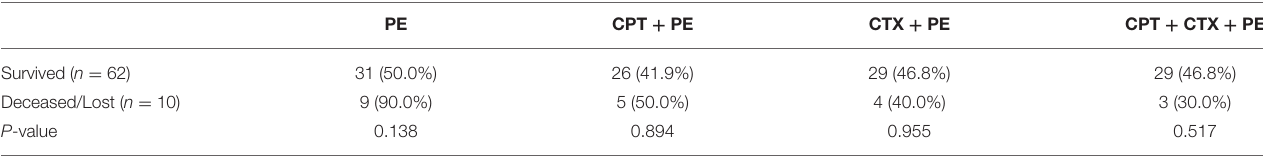
TABLE 4 | Comparisons of treatment between the survival and the deceased group. PE CPT + PE CTX + PE CPT + CTX + PE Survived ( n = 62) 31 (50.0%) 26